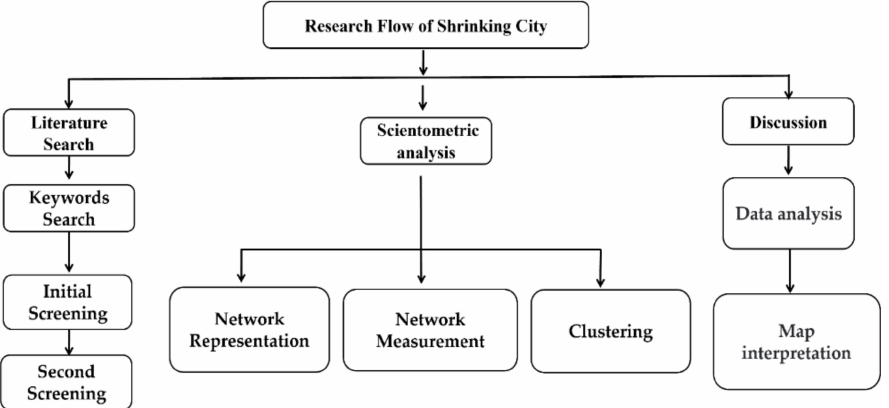
Figure 1. Research flow chart for reviewing the SCT